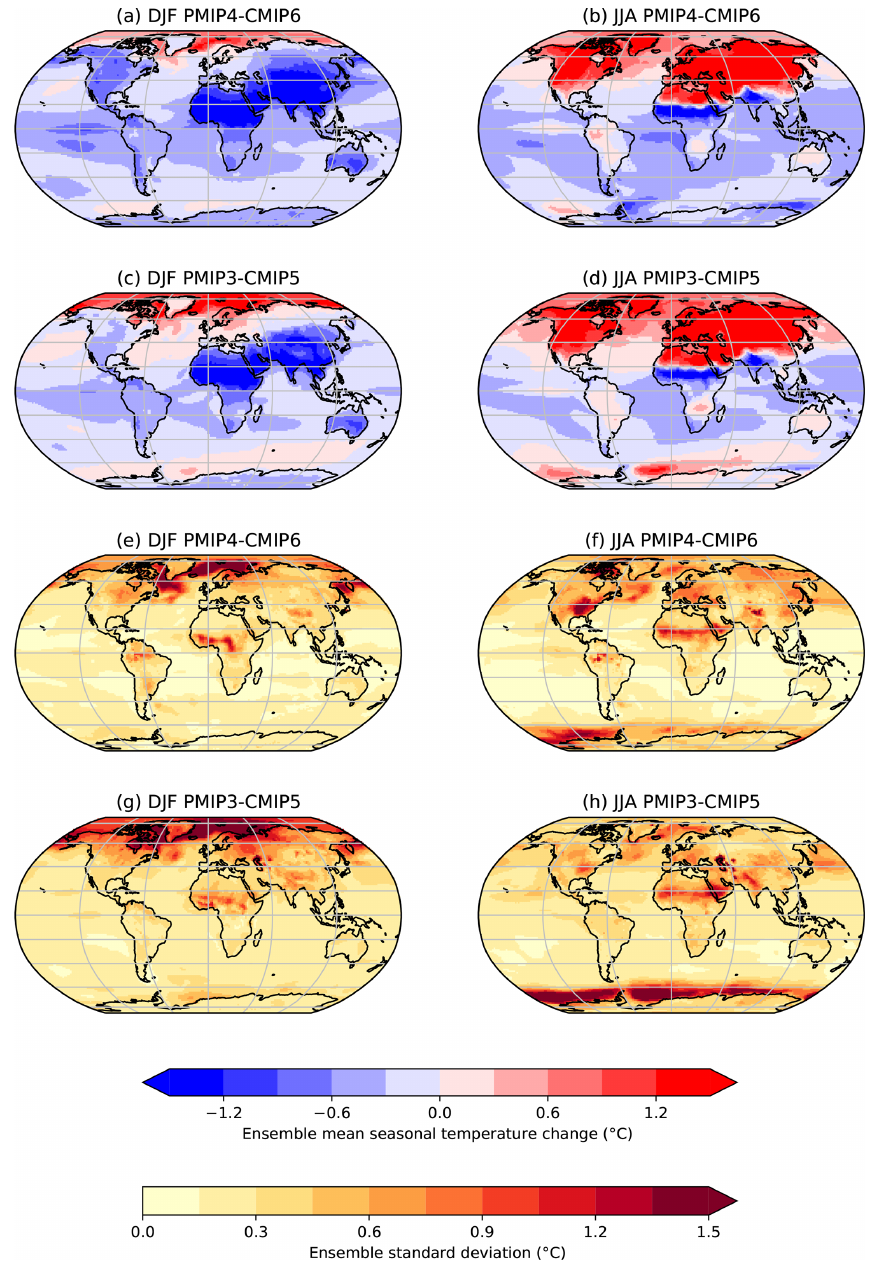
Figure 2. Seasonal surface temperature changes in the midHolocene simulations ( ◦ C). (a, b) The ensemble mean temperature changes in PMIP4-CMIP6 (midHolocene – piControl) in DJF and JJA. (c, d) The ensemble mean temperature changes in PMIP3-CMIP5 in DJF and JJA. The inter-model spread (defined as the across-ensemble standard deviation) in seasonal temperature changes seen across the ensembles: (e) DJF in PMIP4-CMIP6, (f) JJA in PMIP4-CMIP6, (g) DJF in PMIP3-CMIP5, and (h) JJA in